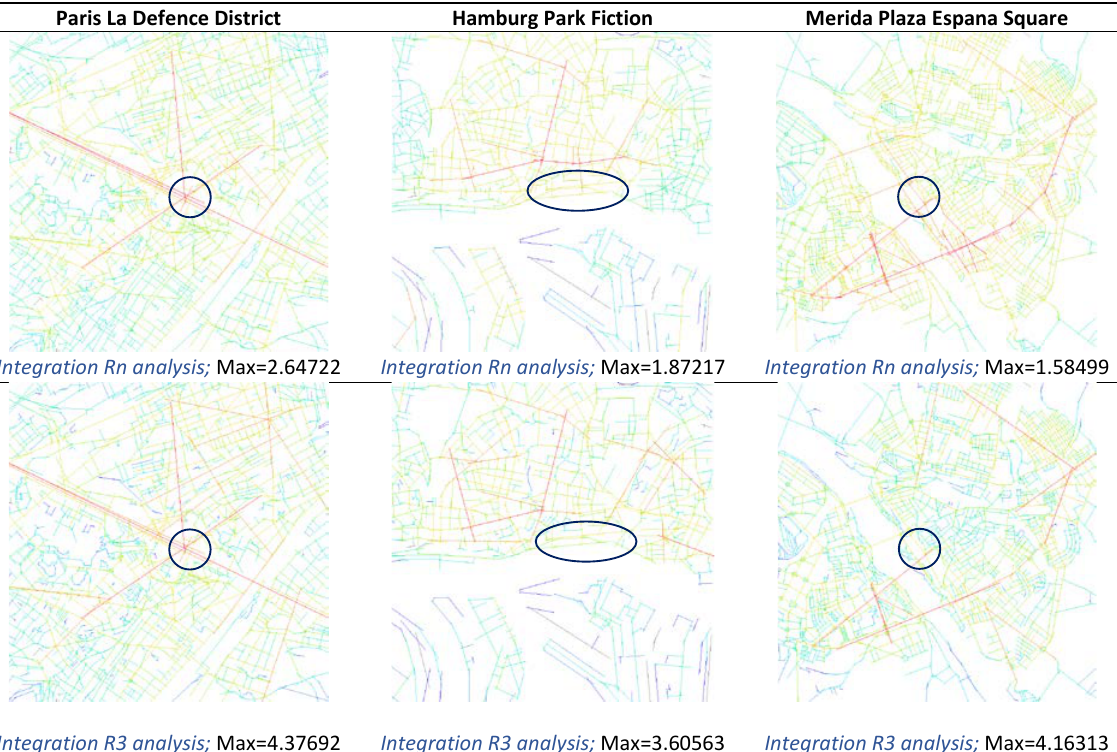
Table 1 Results of the space syntax analyses of rebel cities (continued)